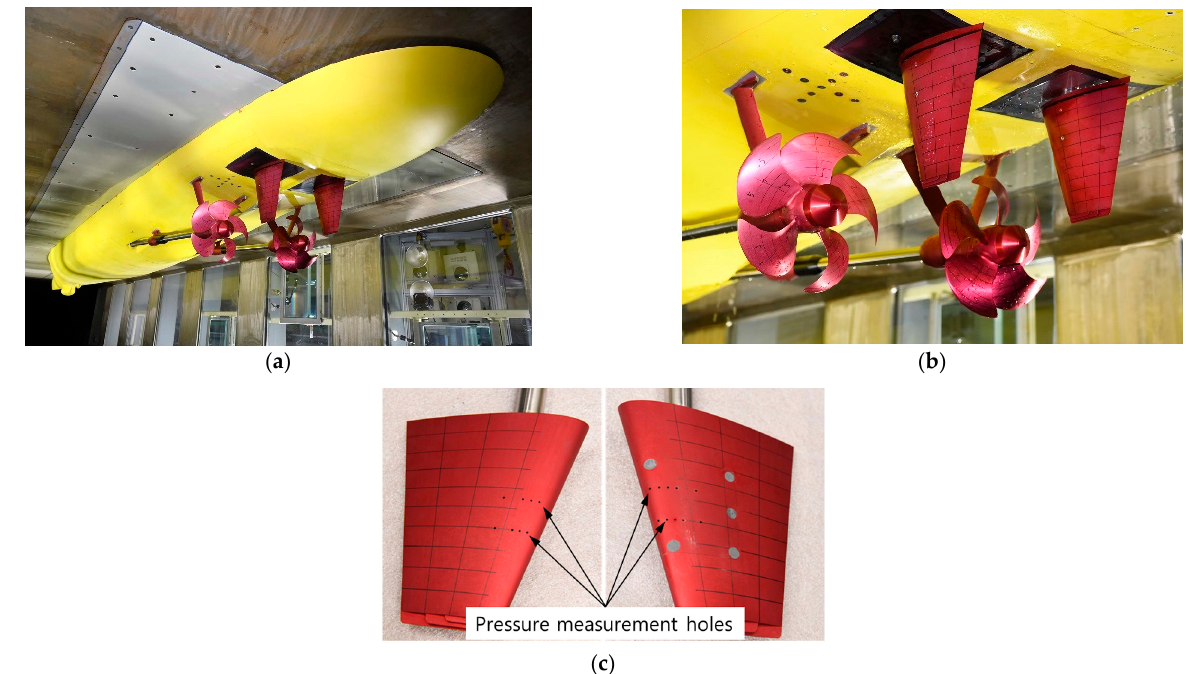
Figure 1. Experimental setup in the LCT: ( a ) full appended ship model mounted in the test section; ( b ) close-up view of the stern region; ( c ) pressure measurement holes on the inboard and outboard surfaces of the port flat rudder. Table 1. Main dimensions of the ship, propeller and rudder models.